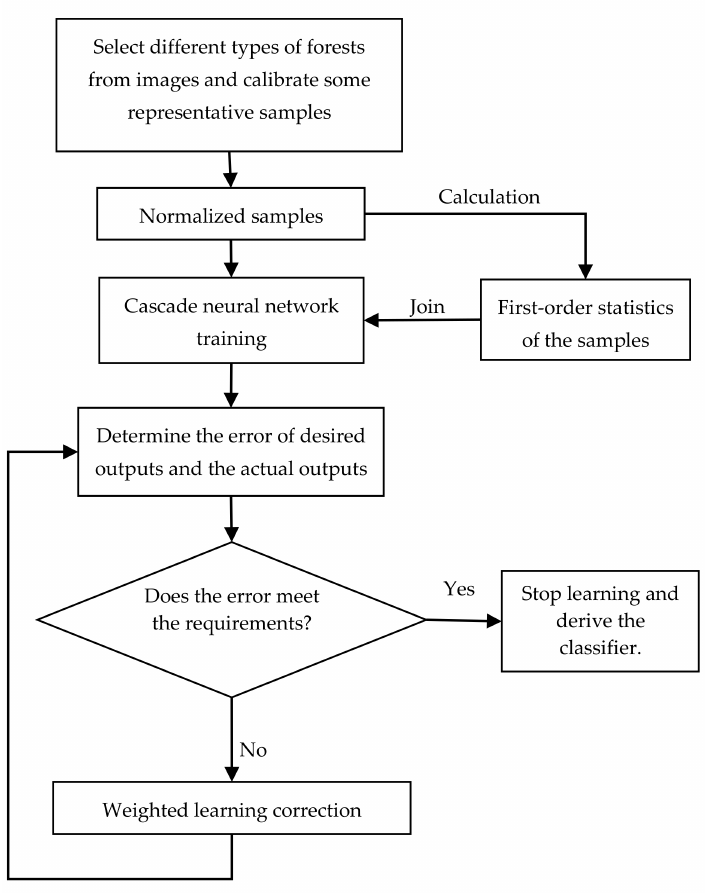
Figure 2. Flowchart for the single-tree detection